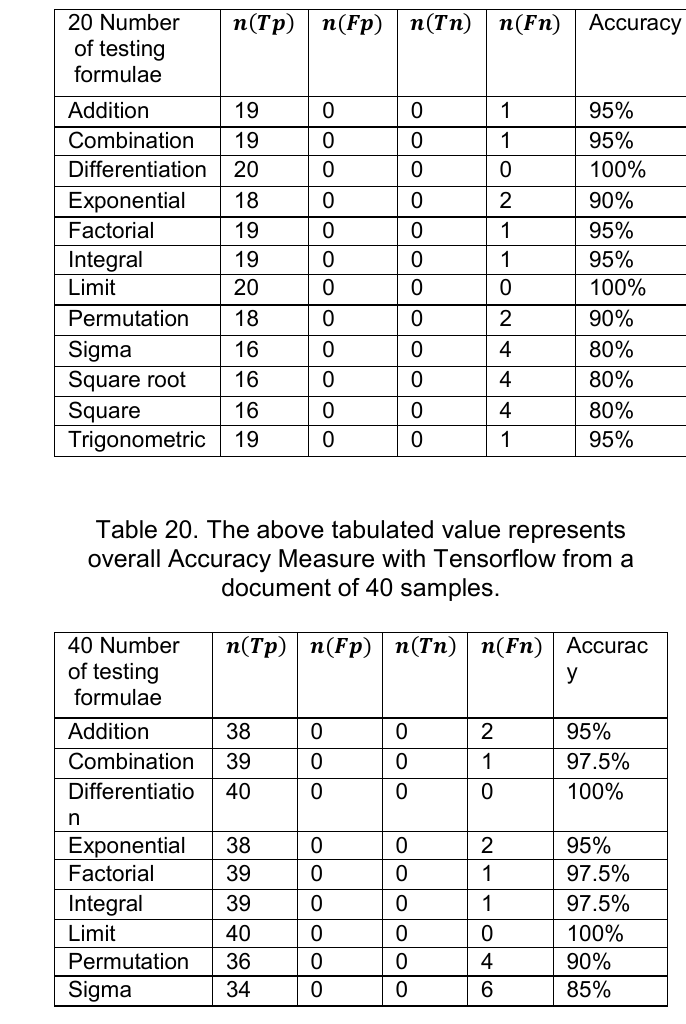
Table 19. The above tabulated value represents overall Accuracy Measure with Tensorflow from a document of 20 samples.